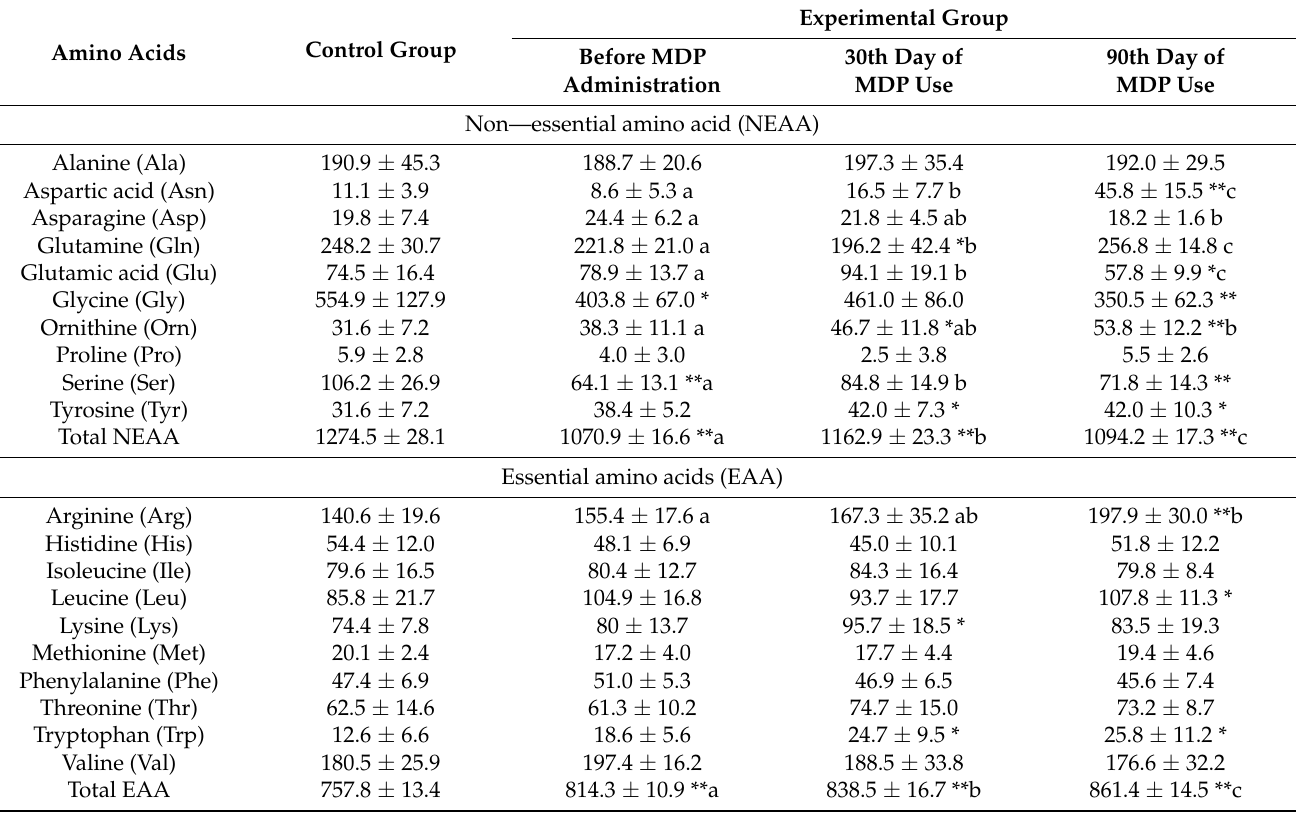
Table 2. The concentration of non-essential and essential amino acid in the blood serum of cows in the control and experimental group [ µ mol/L] (Mean ±